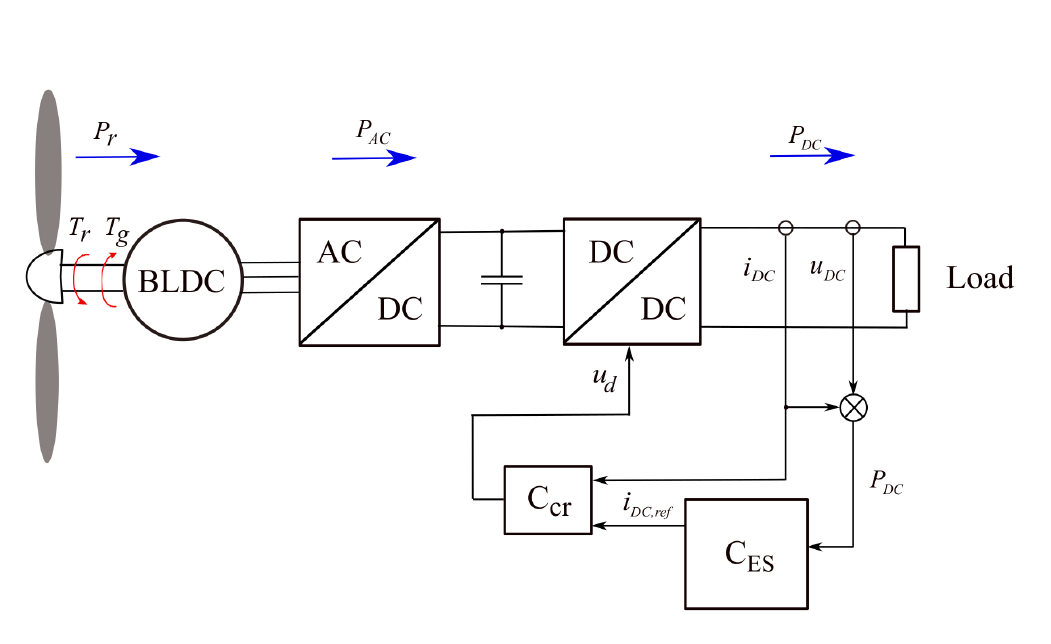
Figure 2. Drive train, power electronics, and control scheme with extremum seeking for small wind turbines in the partial